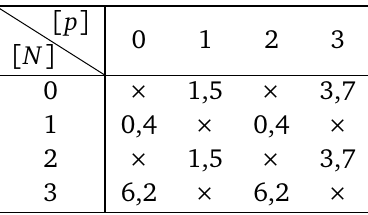
( p ) mod 8 of the minimal Abelian theory N ( p ) mod 8 is one of the two possible values N